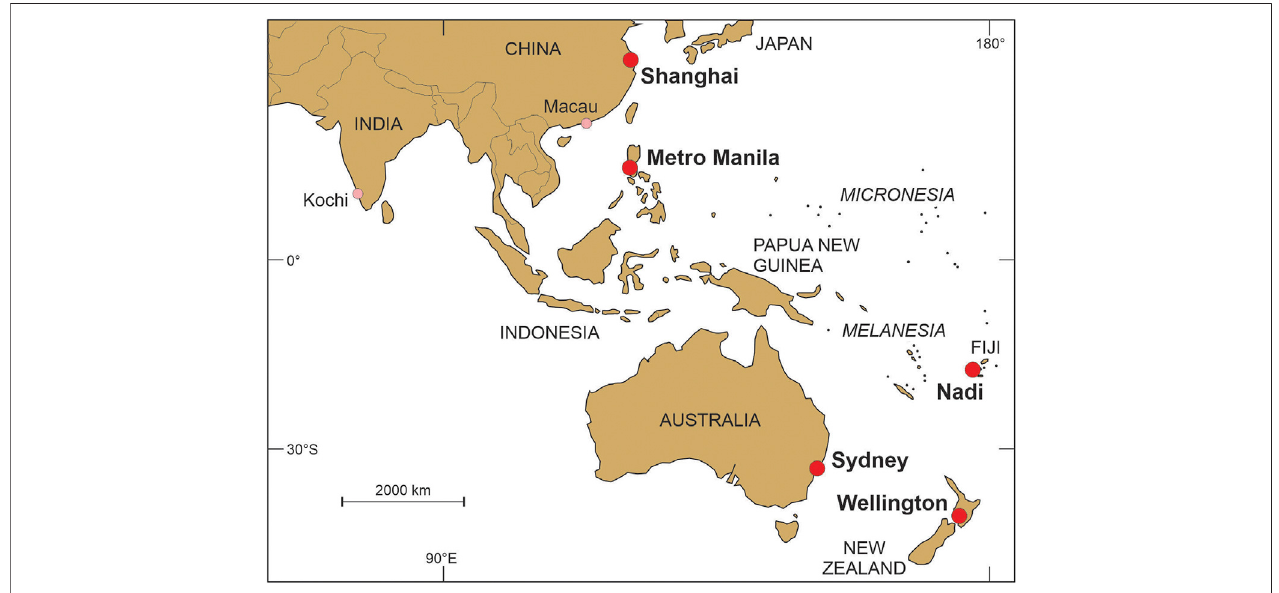
FIGURE 1 | The Asia-Paci fi c region showing the fi ve case study sites (bold) and other places mentioned in the text.